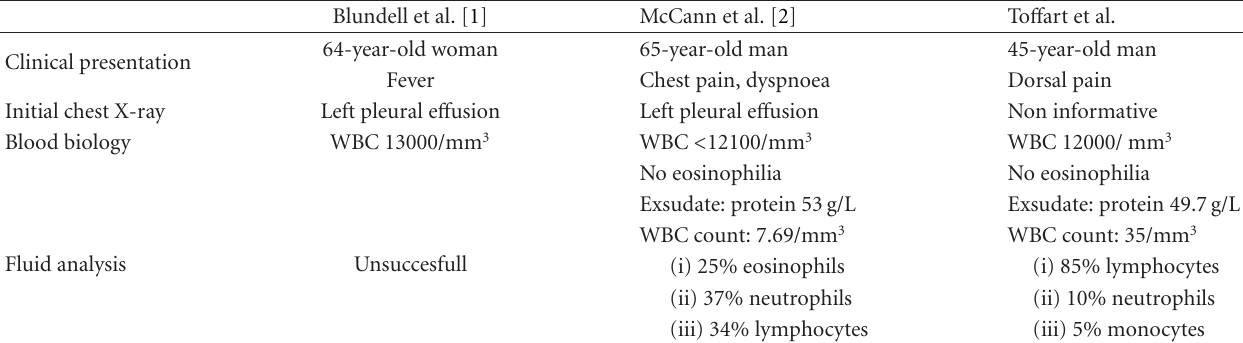
Table 1: Cases published with similar initial pleural e ff usion in Wegener’s